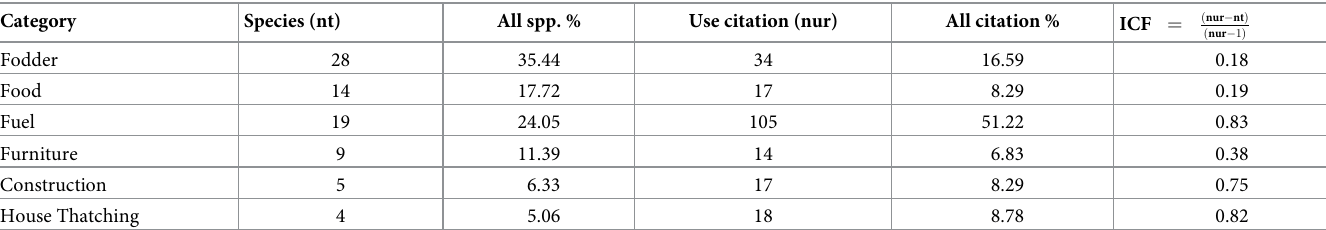
Table 10. Informant consensus factor (ICF) for different categories from Dawarian and Rati Gali, AJK Pakistan (for other purposes).